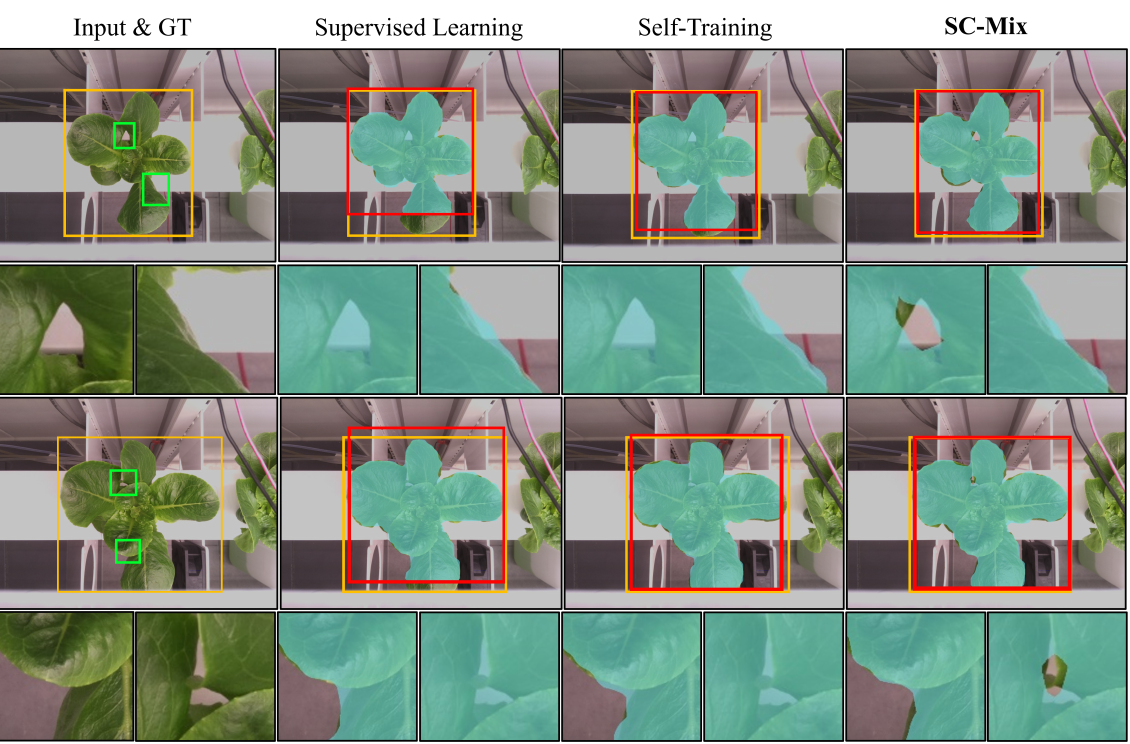
Figure 6. Supervised vs. self-training vs. SC-Mix. This result compared SC-Mix to other model training approaches for non-overlapping crops. The red box is the predicted area of the model, and the yellow box is the ground truth area of the